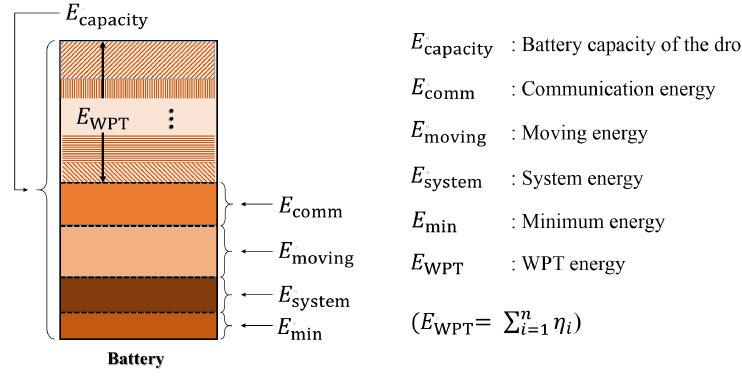
Figure 4. Energy model of the drone.